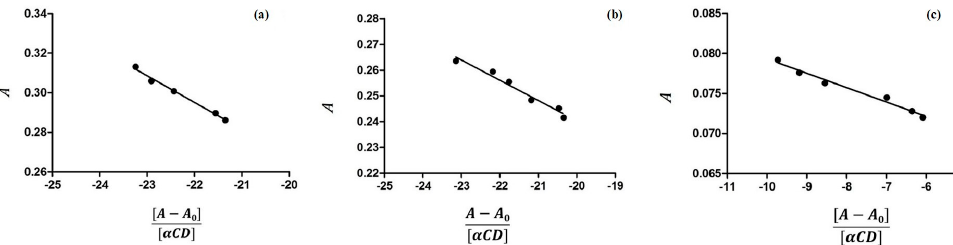
Figure 3. Job plot for the complex 5-FU: α CD ( a ); and for the complex 5-FU: β CD ( b ) at λ = 266 nm.